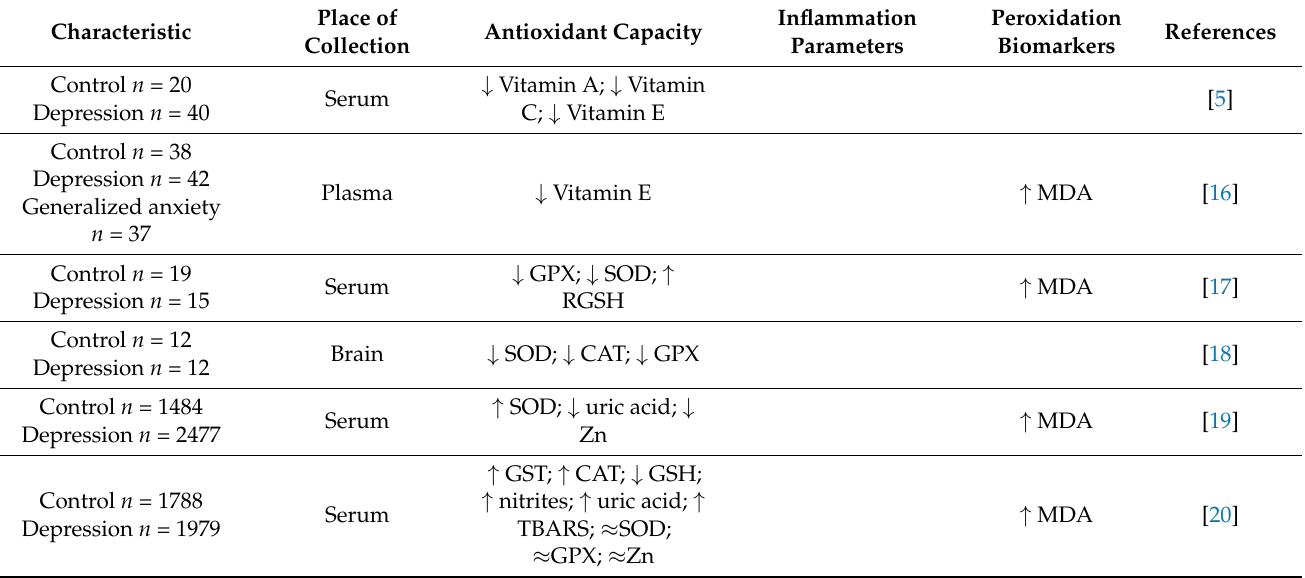
Table 1. Antioxidant capacity and lipid peroxidation biomarkers in depression—review of studies in